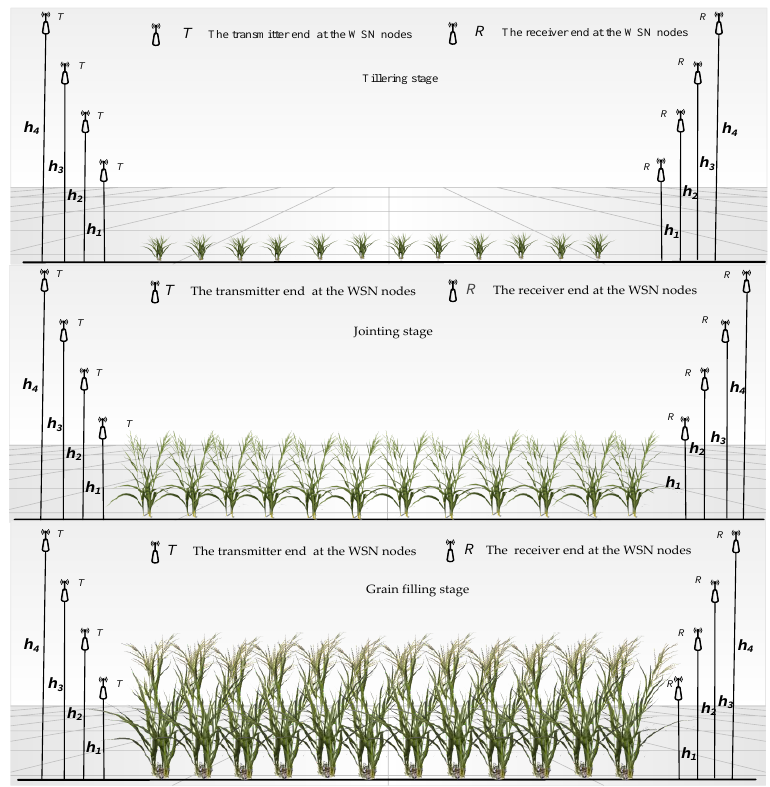
Figure 1. Experiment design of the three scenarios.